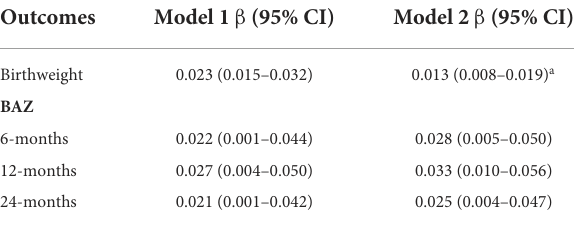
TABLE 2 Unadjusted and adjusted correlations between total gestational weight gain and birthweight and age-specific